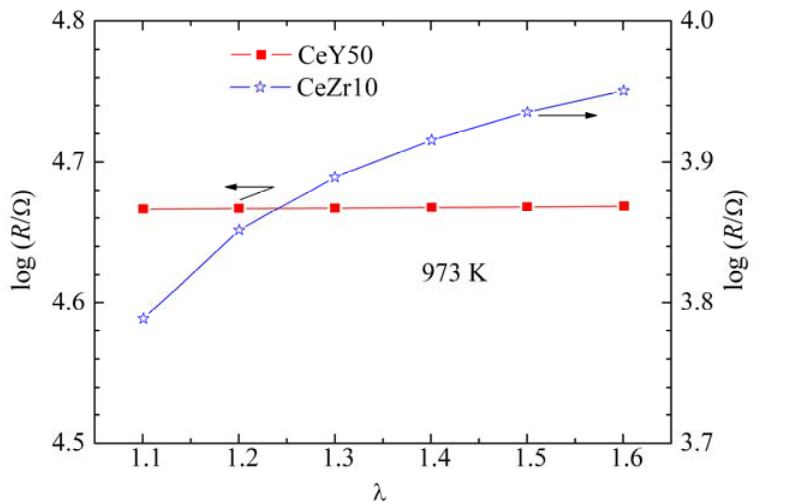
Figure 5. Dependence of the resistance on  for CeY50 (Ce Zr O (Ce 0.9 0.1 2